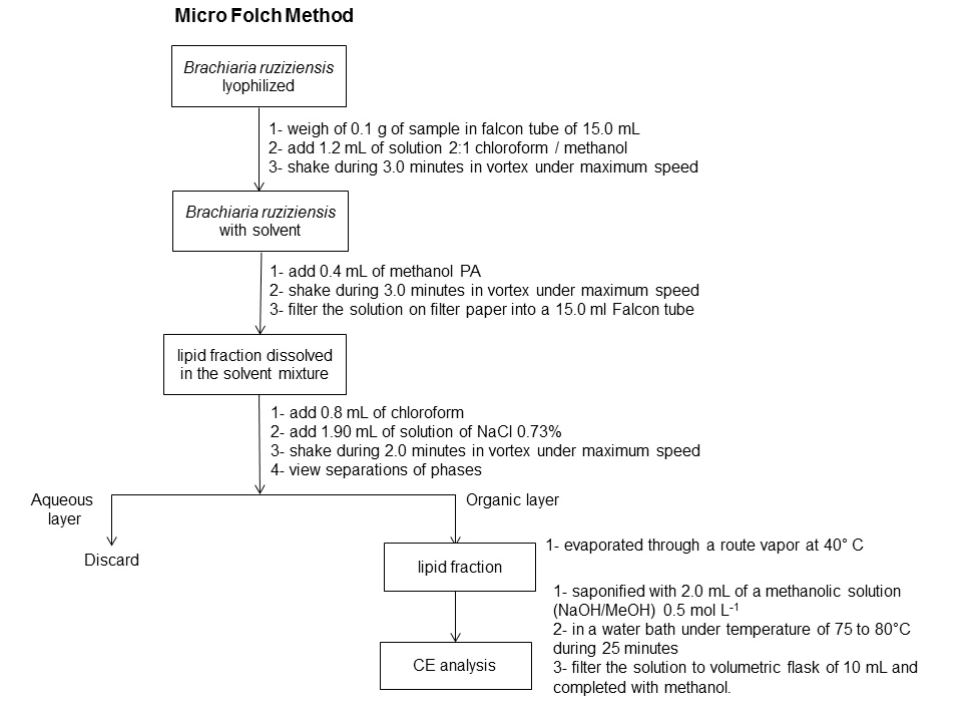
Figure 3. Micro Folch extraction methods flow